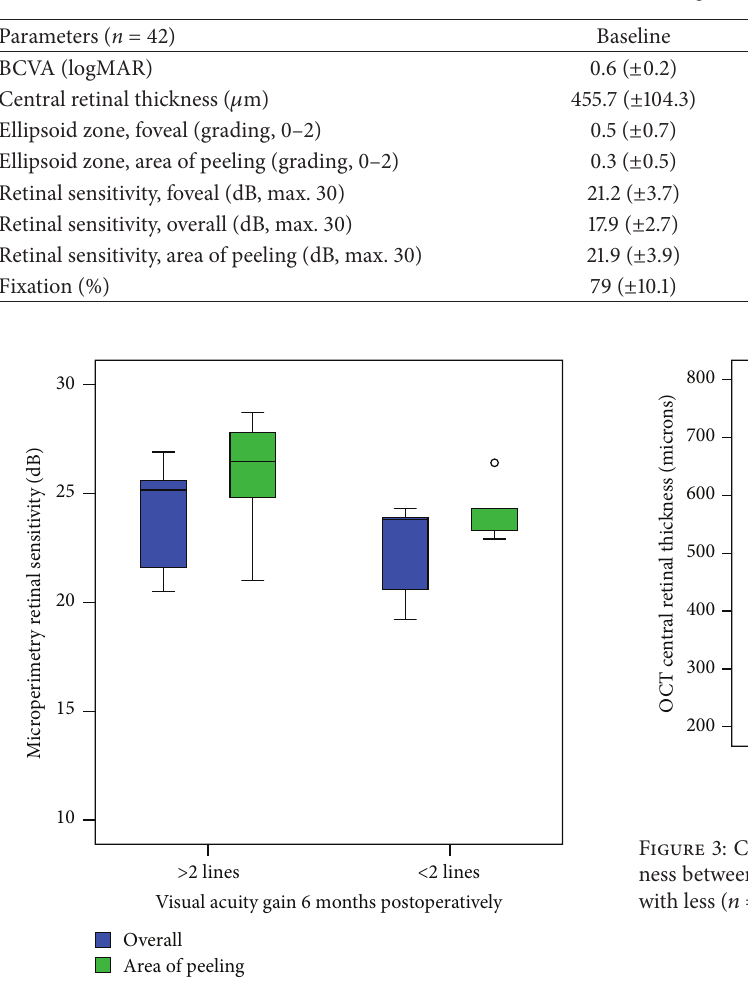
Figure 2: Mean retinal sensitivity in microperimetry measurements overall (18 ∘ , blue box) and areas of peeling (2 ∘ , green box) based on visual acuity gain 6 months postoperatively. No significant correlation between retinal sensitivity in areas of peeling and overall measurements ( 𝑝 = 0.08 ).